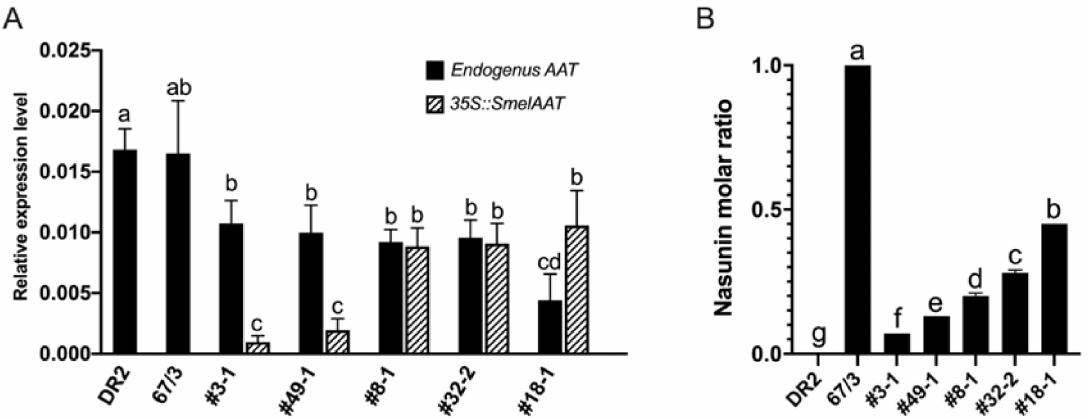
Figure 6. Overexpression of p35S::SmelAAT in 305E40_aat ‘DR2’ genotype. ( A ) RT-qPCR expression analysis of SmelAAT (in line ‘67/3’), 305E40_aat and p35S::SmelAAT in eggplants’ peel samples of ‘DR2’ and five T1 transformants of ‘DR2’. Data are the means of three biological replicates ± SD. ( B ) NAS molar ratio over the total amount of anthocyanin (NAS+D3R) in peel of ‘DR2’, ‘67/3’, and the five p35S::SmelAAT transformants. Different letters in ( A,B ) indicates significant differences at p < 0.05 (Tukey’s